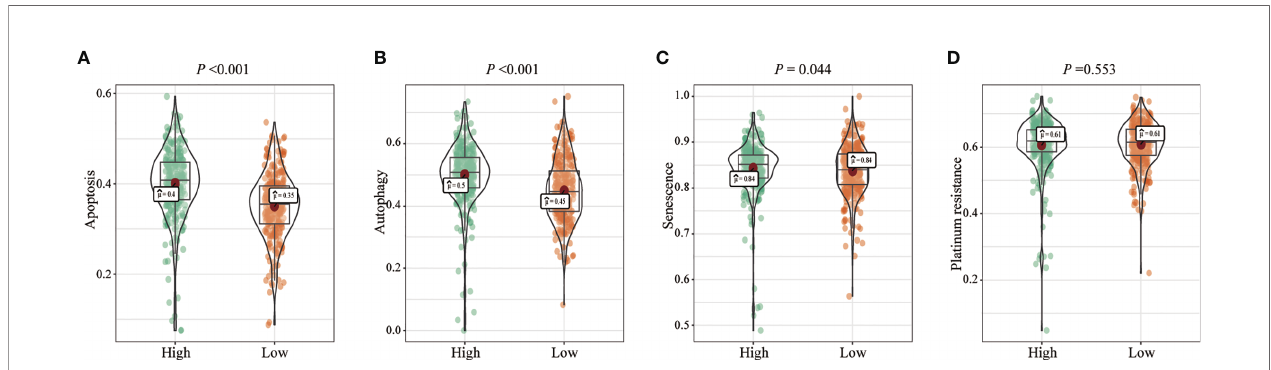
FIGURE 4 | Correlation between fetal-lethal non-coding developmental regulatory RNA (FENDRR) expression and biological pathways. (A – D) Association of FENDRR expression with apoptosis ( p < 0.001), autophagy ( p < 0.001), senescence ( p = 0.044), and platinum resistance score ( p = 0.553).